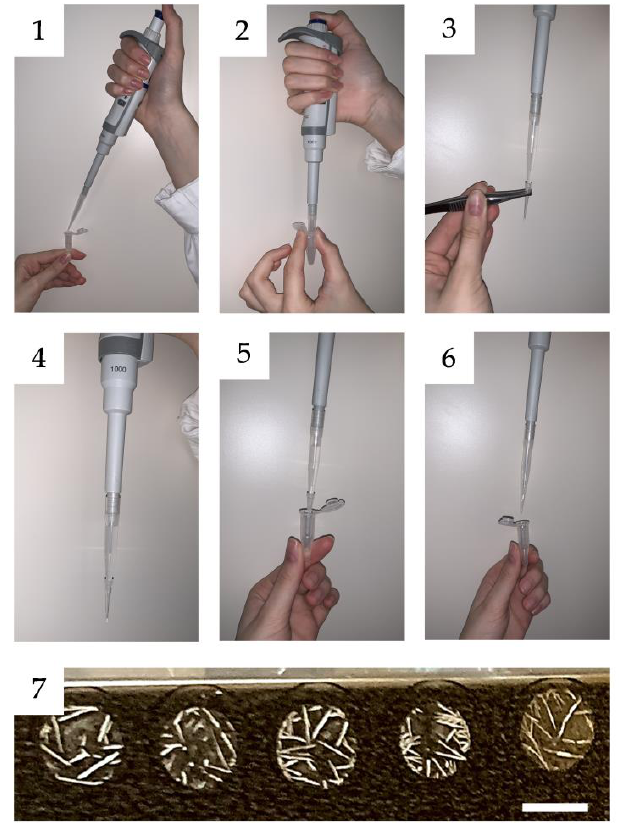
Figure 5. Modified ZipTip protocol for improving cell proteomic footprinting. In total, 1 mL of